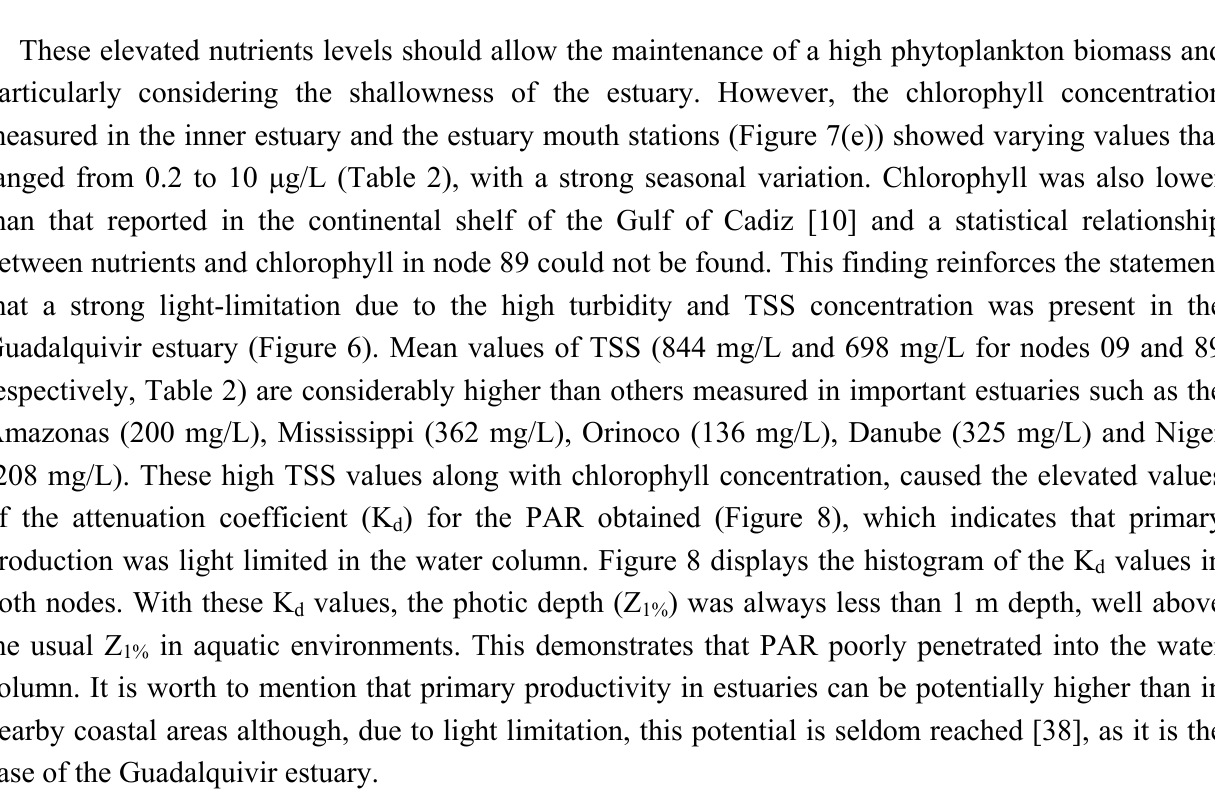
) for node 09 and node 1%